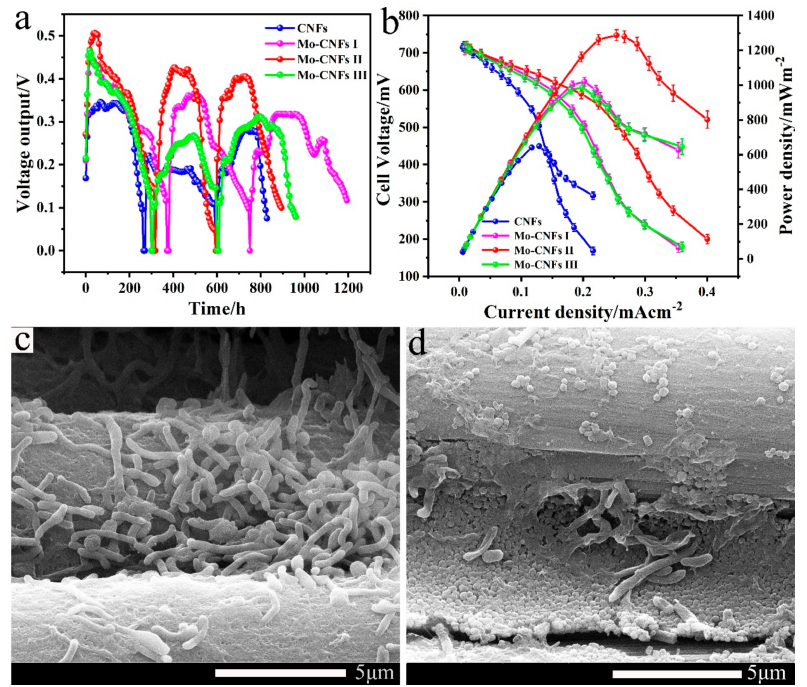
Figure 5. Performance comparison of different electrodes in MFCs. ( a ) Cyclic discharge curves. ( b ) Power density and polarization curves. SEM image of bacterial cells grown on ( c ) Mo-CNF II and ( d ) CNF anode after three-cycle